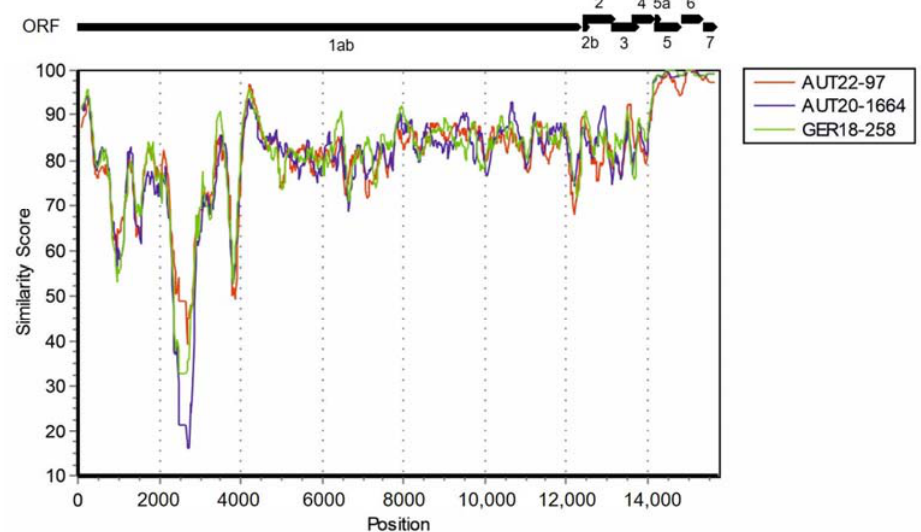
Figure 2. Similarity plot of three PRRSV isolates compared to MLV vaccine PRRSFLEX. A Kimura 2- parameter test with a transition/transversion (Ts/Tv) ratio of 2.0 was performed with the PRRSFLEX sequence as a query. The scheme above the plot shows the positions of the PRRSV open reading frames (ORFs).